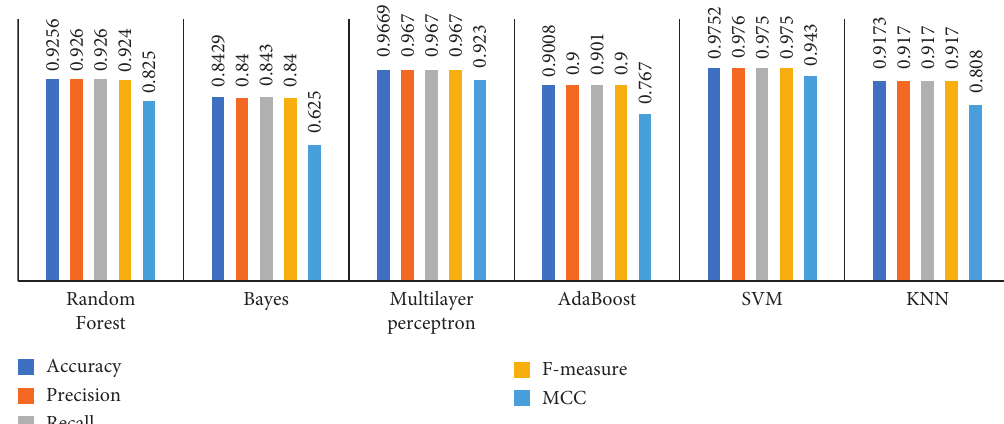
Figure 12: Classifier evaluation measures for texture and color